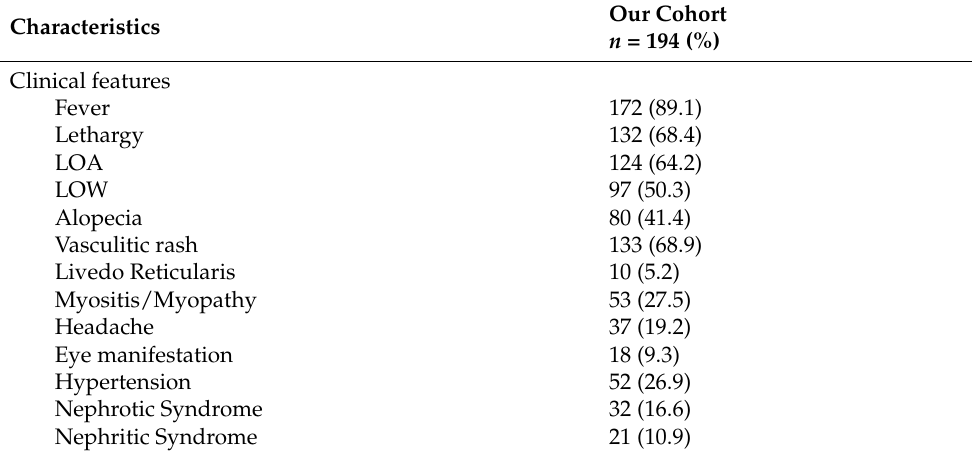
Table 2. Clinical features at diagnosis of 194 Malaysian children with